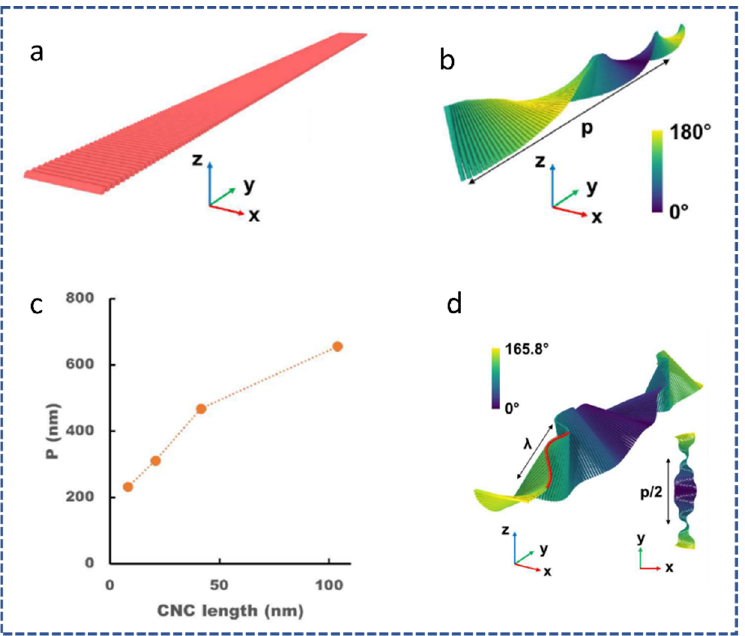
Figure 3. Molecular dynamic simulation of CNC chirality investigation. ( a ) Initial model structure with 180 CNCs of length ∼ 41.5 nm side-by-side with (110) surfaces facing each other and corre- sponding equilibrated cholesteric ribbons. Adapted with permission from Ref. [69]. Copyright 2020 American Chemical Society. ( b ) Pitch as a function of the CNC length. Adapted with permission from Ref. [69]. Copyright 2020 American Chemical Society. ( c ) Schematic of CNC composite bundle. ( d ) The modelled particle has a cholesteric ribbon for CNC with a length of 100 nm and undulation with a wavelength equal to λ . Adapted with permission from Ref. [69]. Copyright 2020 American Chemical